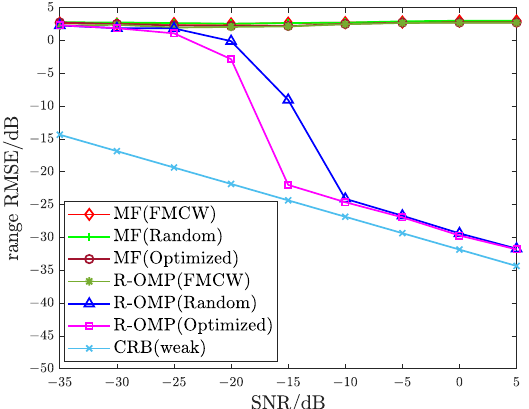
Figure 14. Range RMSE of weak